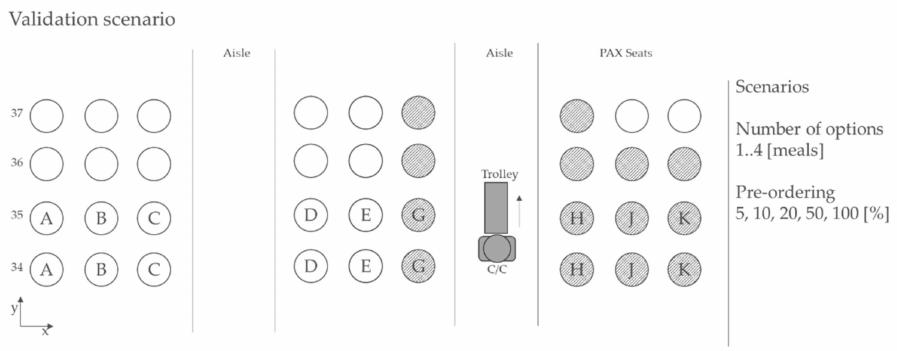
Figure 17. Validation